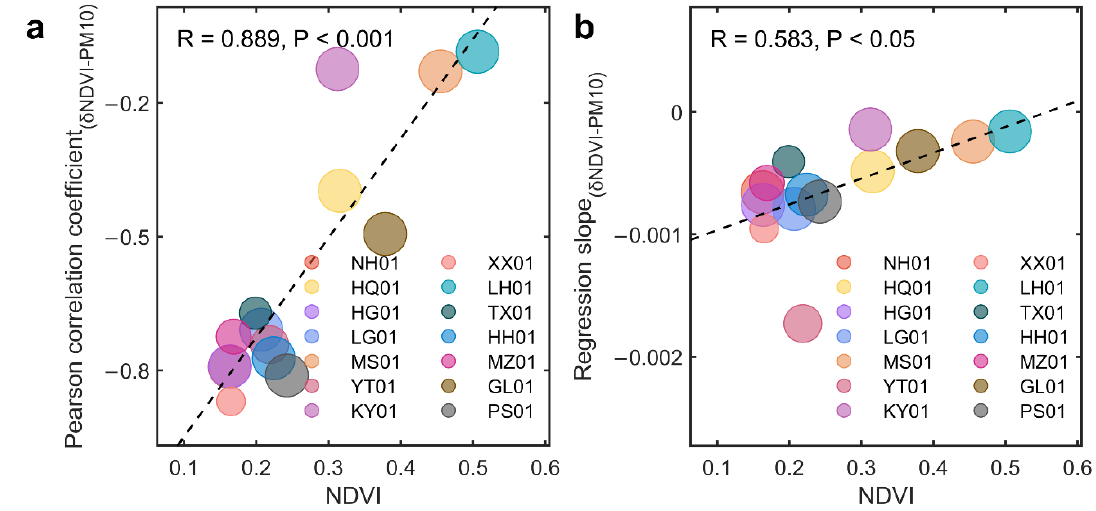
Figure 5. Normalized difference vegetation index (NDVI)-dependent δ NDVI-PM10 relationship. ( a ) Fitting between NDVI and Pearson correlation coefficient of δ NDVI versus atmospheric PM10 concentration. ( b ) Fitting between NDVI and regression slope of δ NDVI versus atmospheric PM10 concentration. The radius of the solid circle represents the number of available data values at a station. The radius of the solid circle represents the number of available data at a